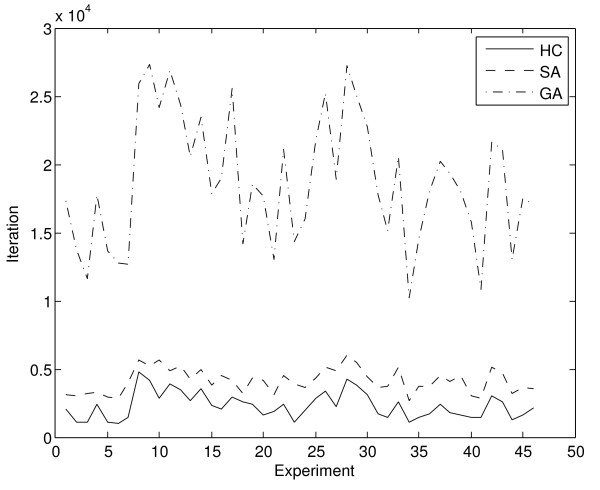
Mean convergence per experiment and method. The hill climbing method (solid line) is the fastest, closely followed by the simulated annealing (dashed line) approach, while the genetic algorithm (dotted line) proves significantly slower.